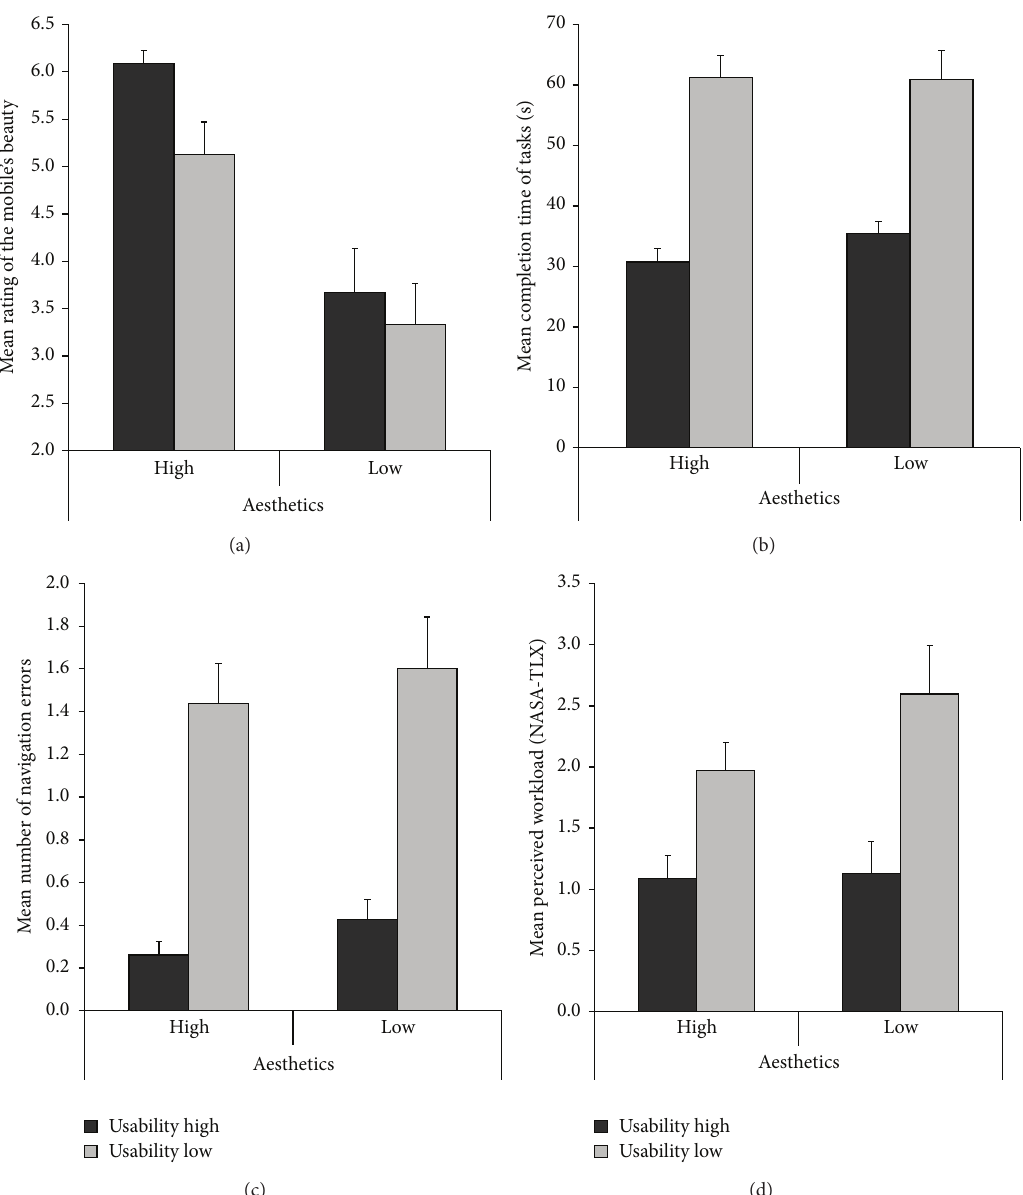
Figure 5: The impact of the mobile versions differing in manipulated usability (high versus low) and manipulated aesthetics (high versus